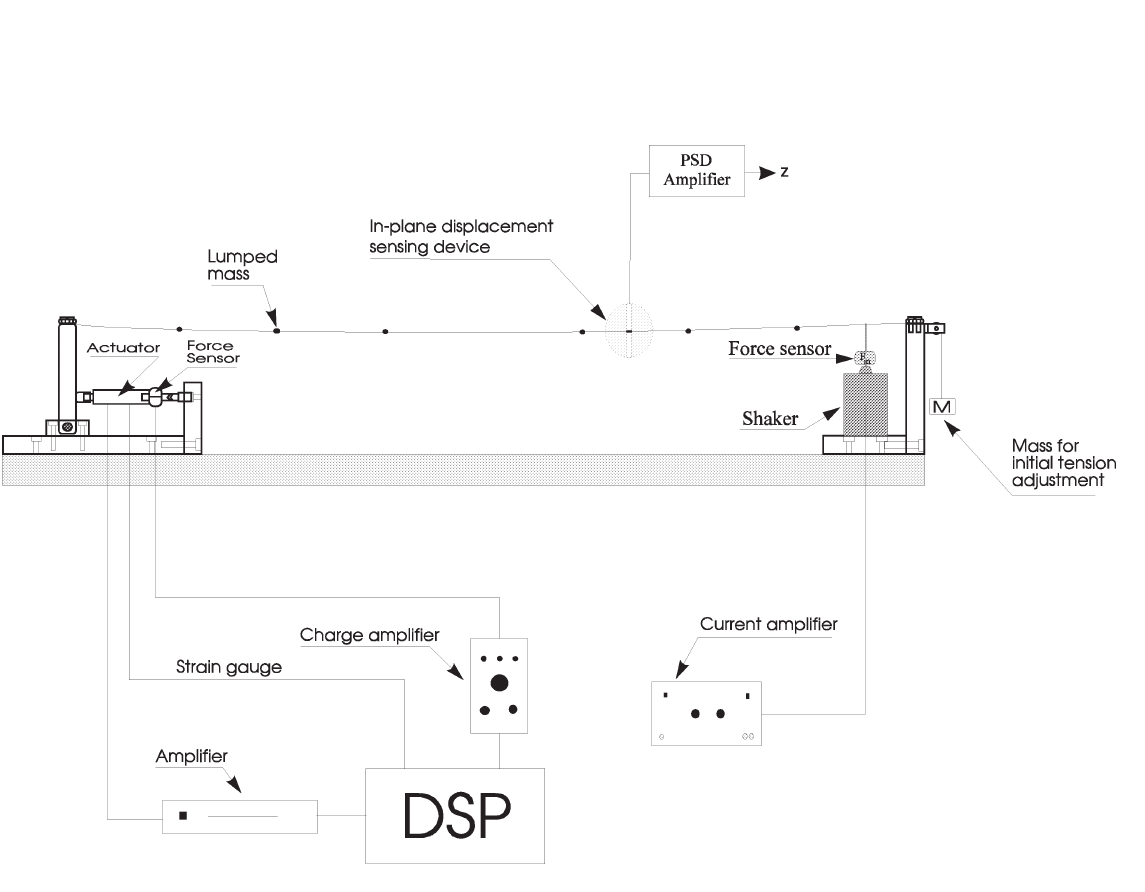
Fig. 7. Cable test